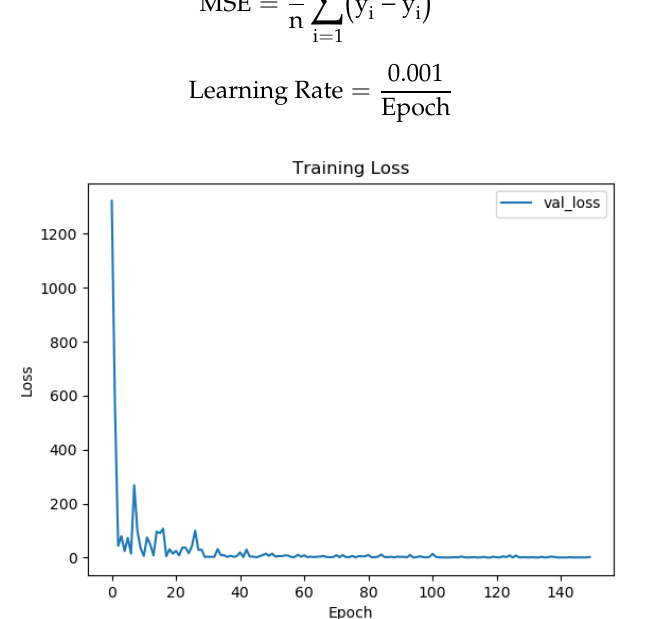
Figure 14. The architecture of the deep neural network (DNN) distance estimation system.